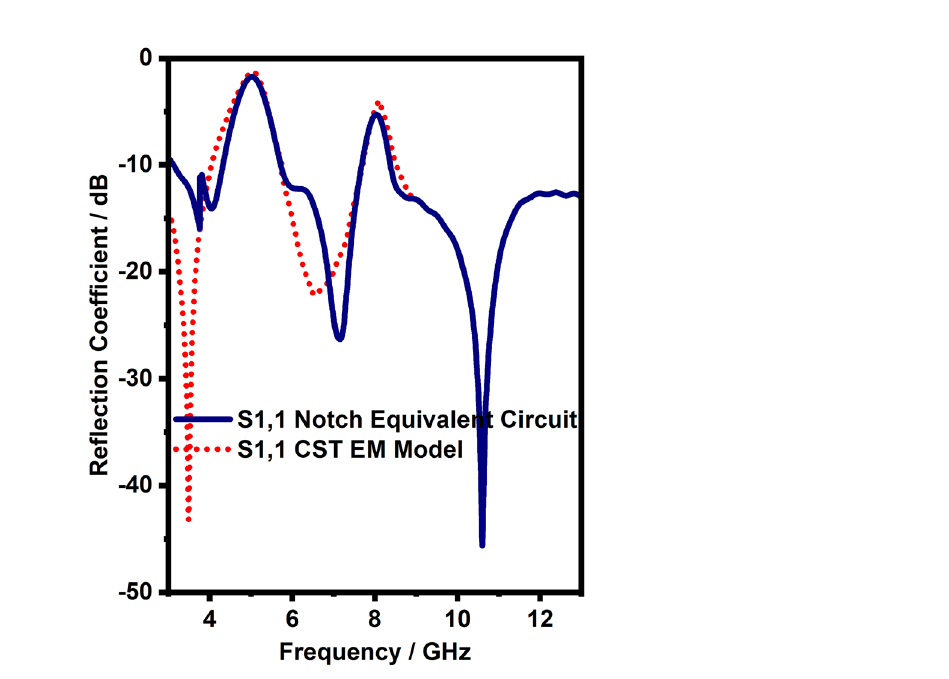
Figure 9. EM model and the lumped circuit model S-parameters for dual band notch (5 and 8 GHz)